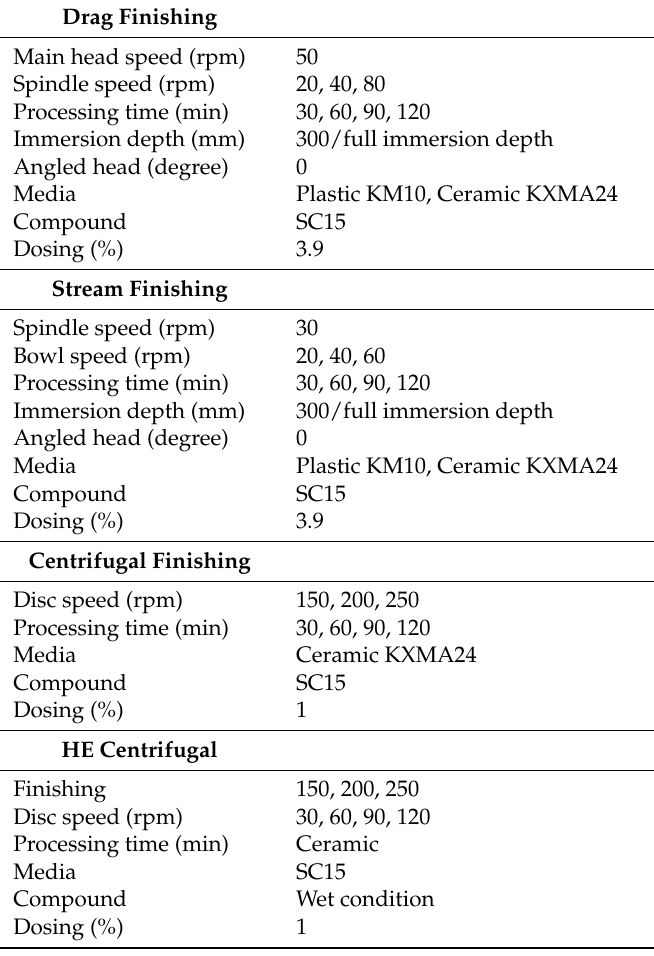
Table 3. Full range of machining parameters. HE: